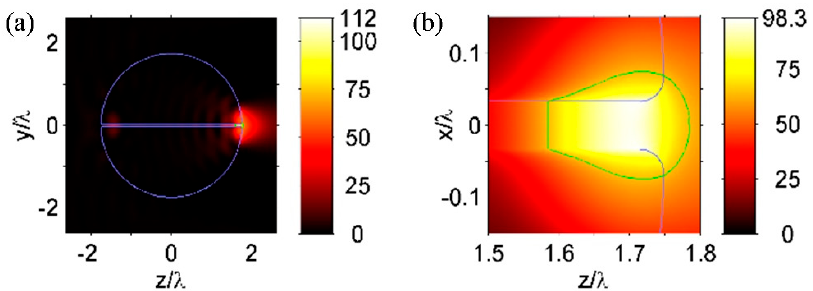
Figure 2. Field localization by nanostructured spherical particle at d = λ / 15 in ( a ) zy plane and ( b ) zx plane [36].